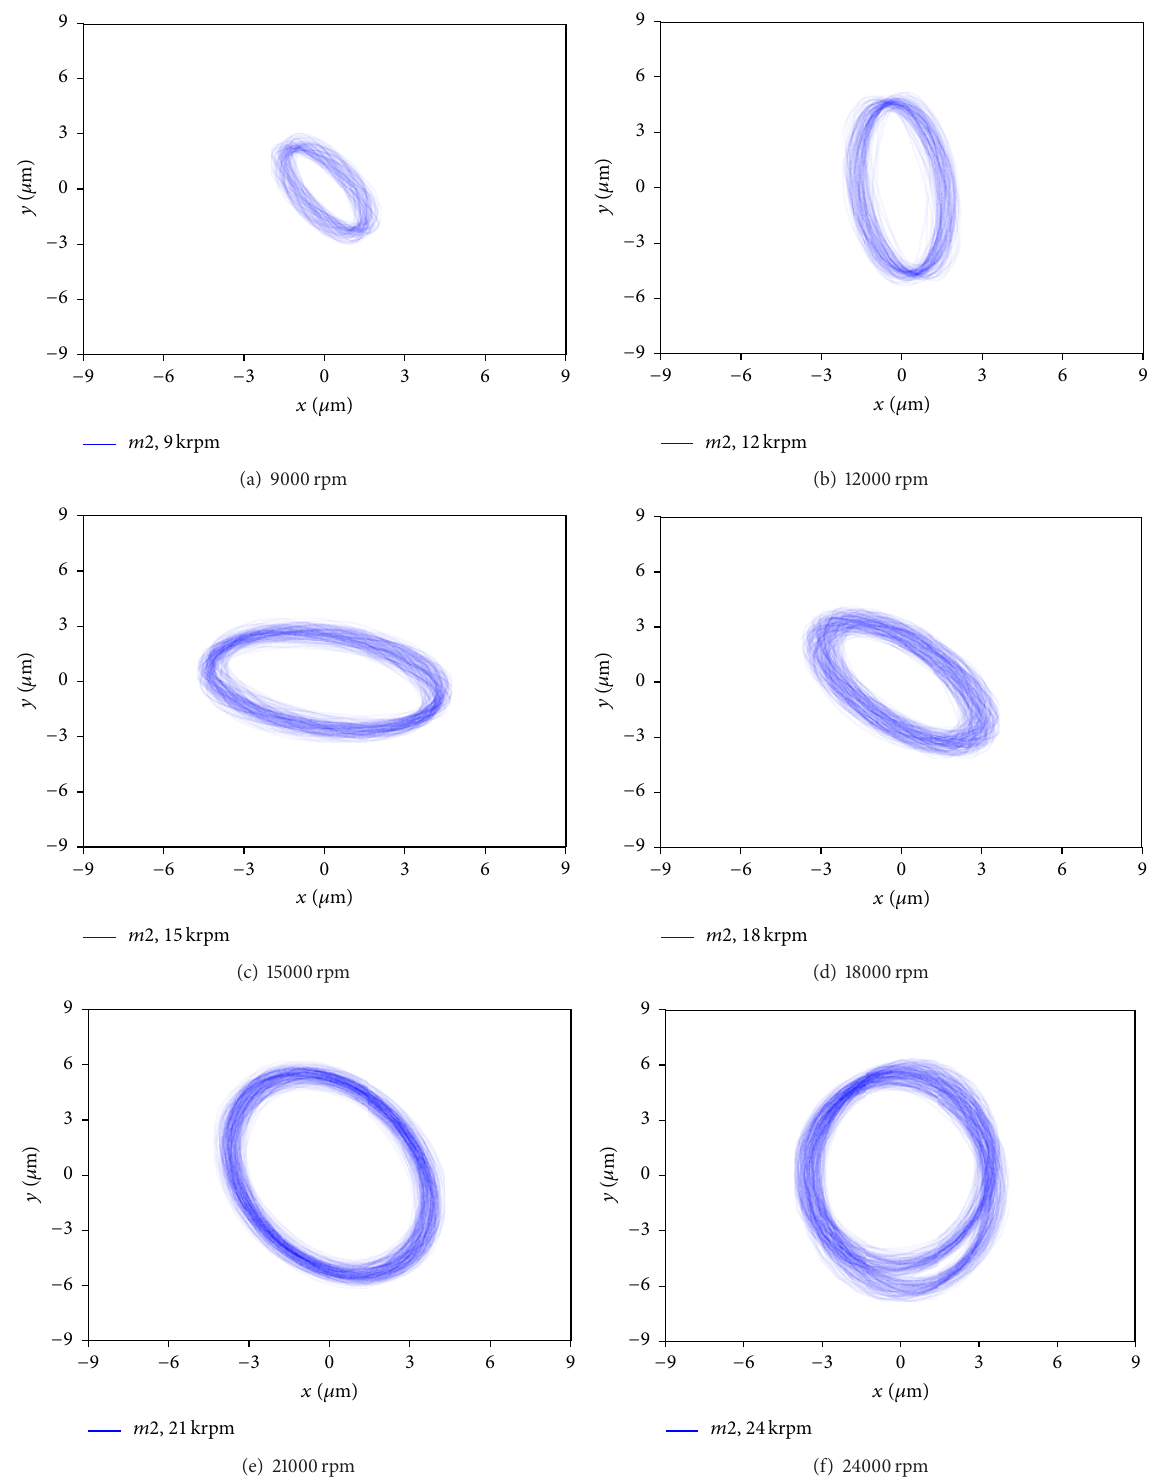
Figure 8: Orbits of the front bearing with an attached unbalance mass m 2 = 3.0